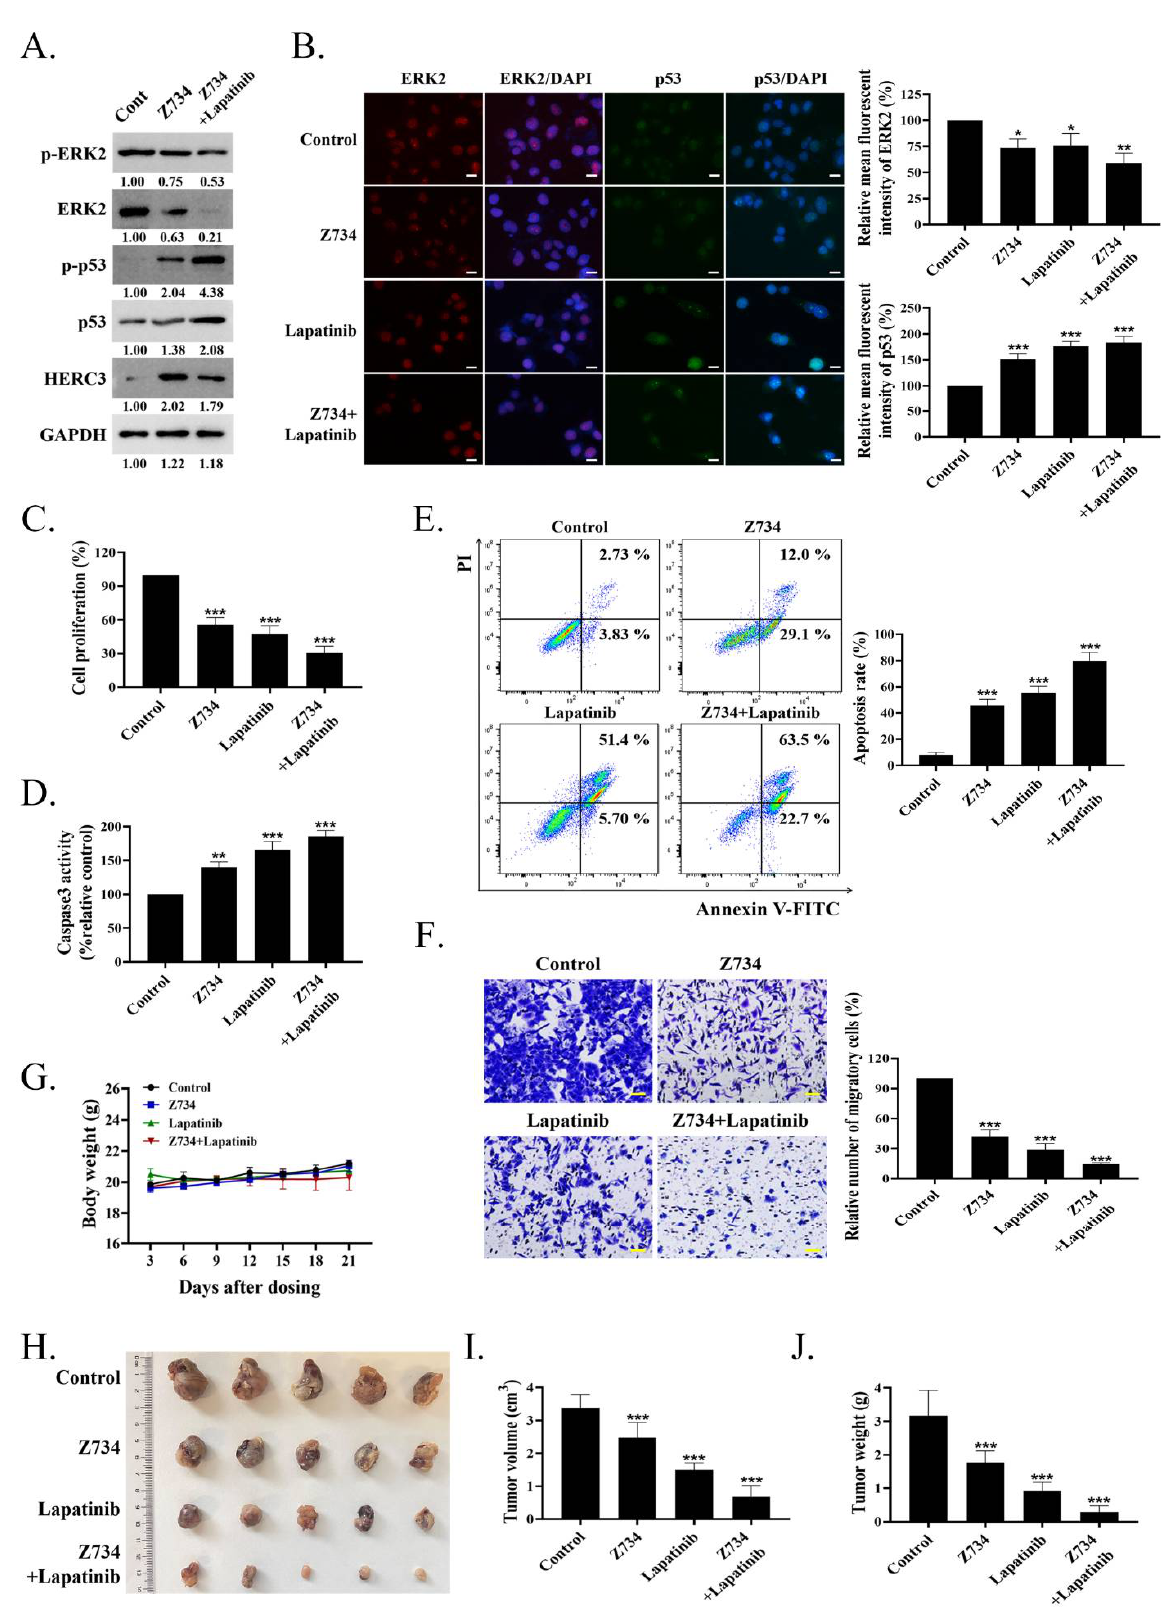
Figure 6. A combination of Z734 and lapatinib inhibits the growth of breast cancer. ( A ) MCF–7 cells were incubated with Z734 (10 μM) and/or lapatinib (0.5 μM), and p–ERK2, ERK2, p–p53, p53 and HERC3 protein expressions were detected by WB. ( B ) Representative images of ERK2 and